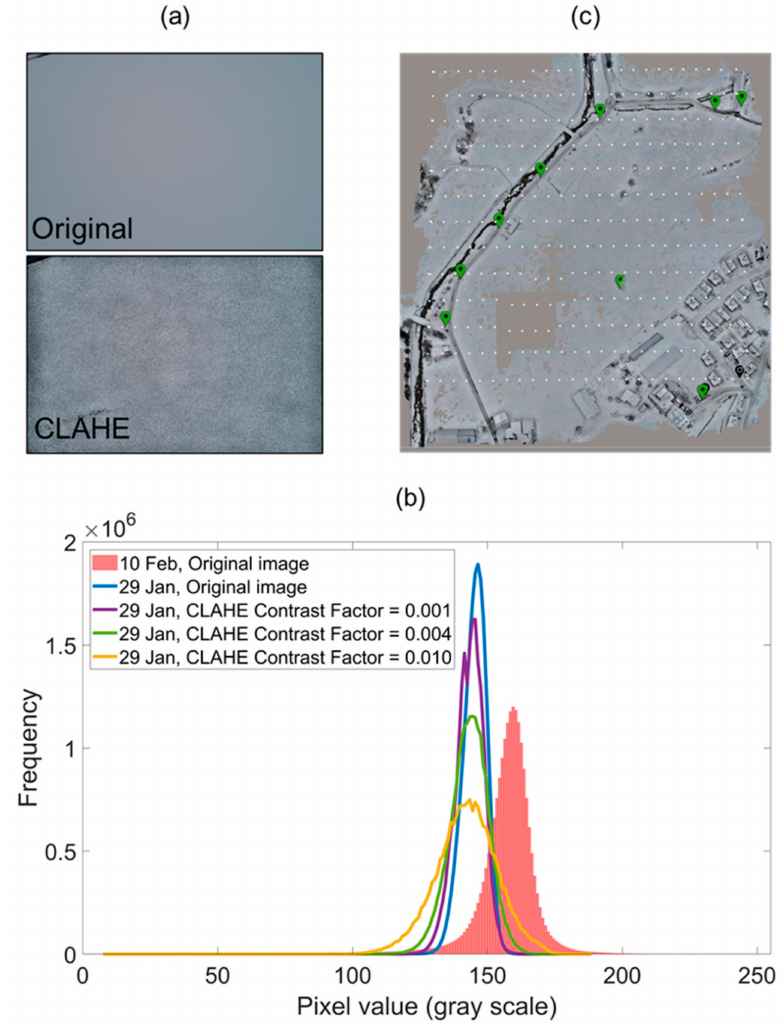
Figure 15. ( a ) Comparison original image (above) and CLAHE image (below). ( b ) Gray scale histogram: image of 10 February (bar) and 29 January (line) at the same position, respectively. ( c ) Constructed DSM using CLAHE filtered